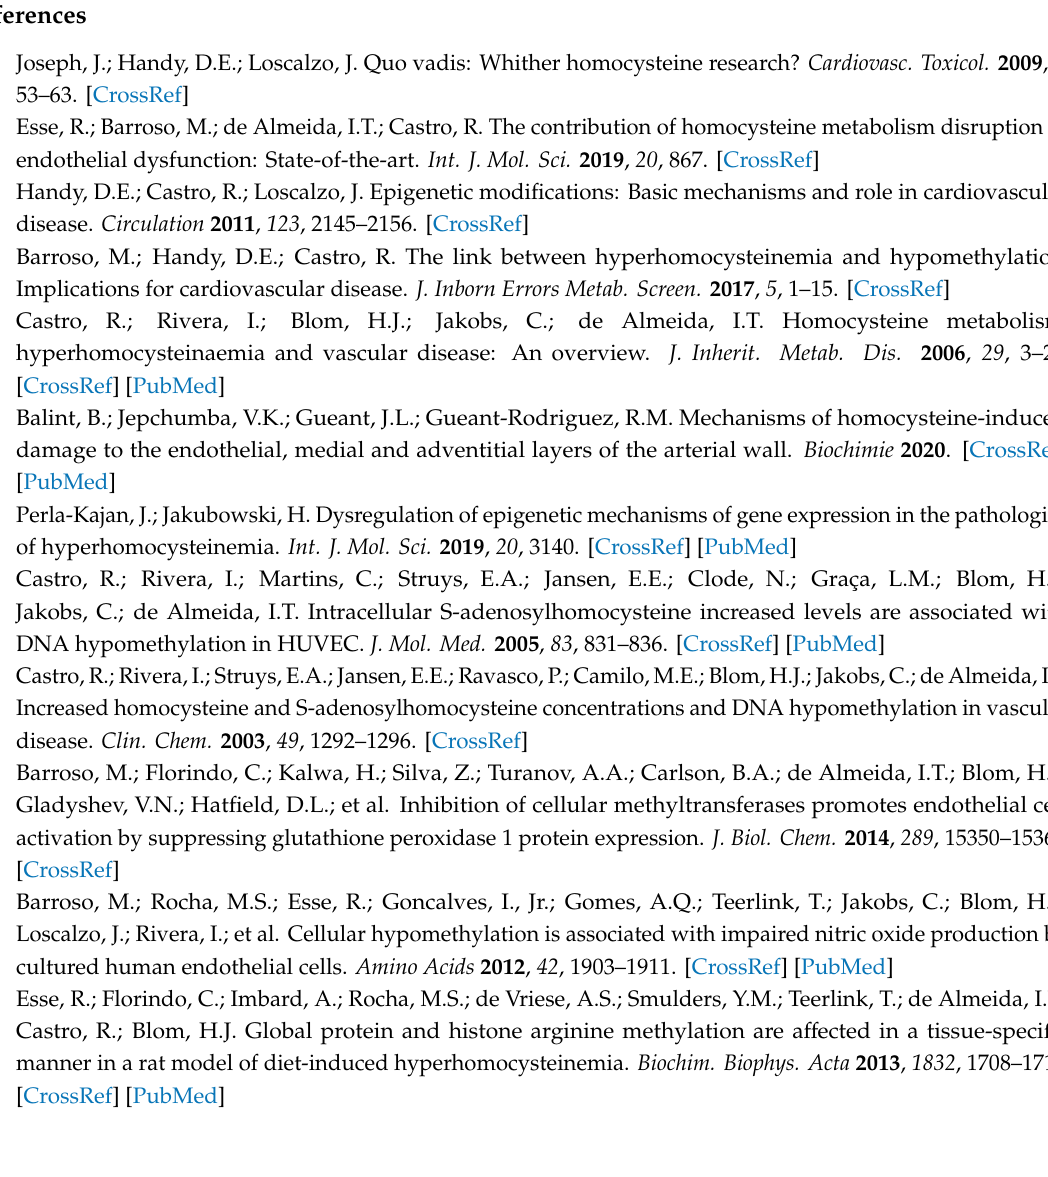
Table S1. Composition of the experimental diets (Control; HF, High Fat; HFLM, High Fat Low Methyl). Figure S1. Lack of fluorescence from Oil Red O post processing for IF